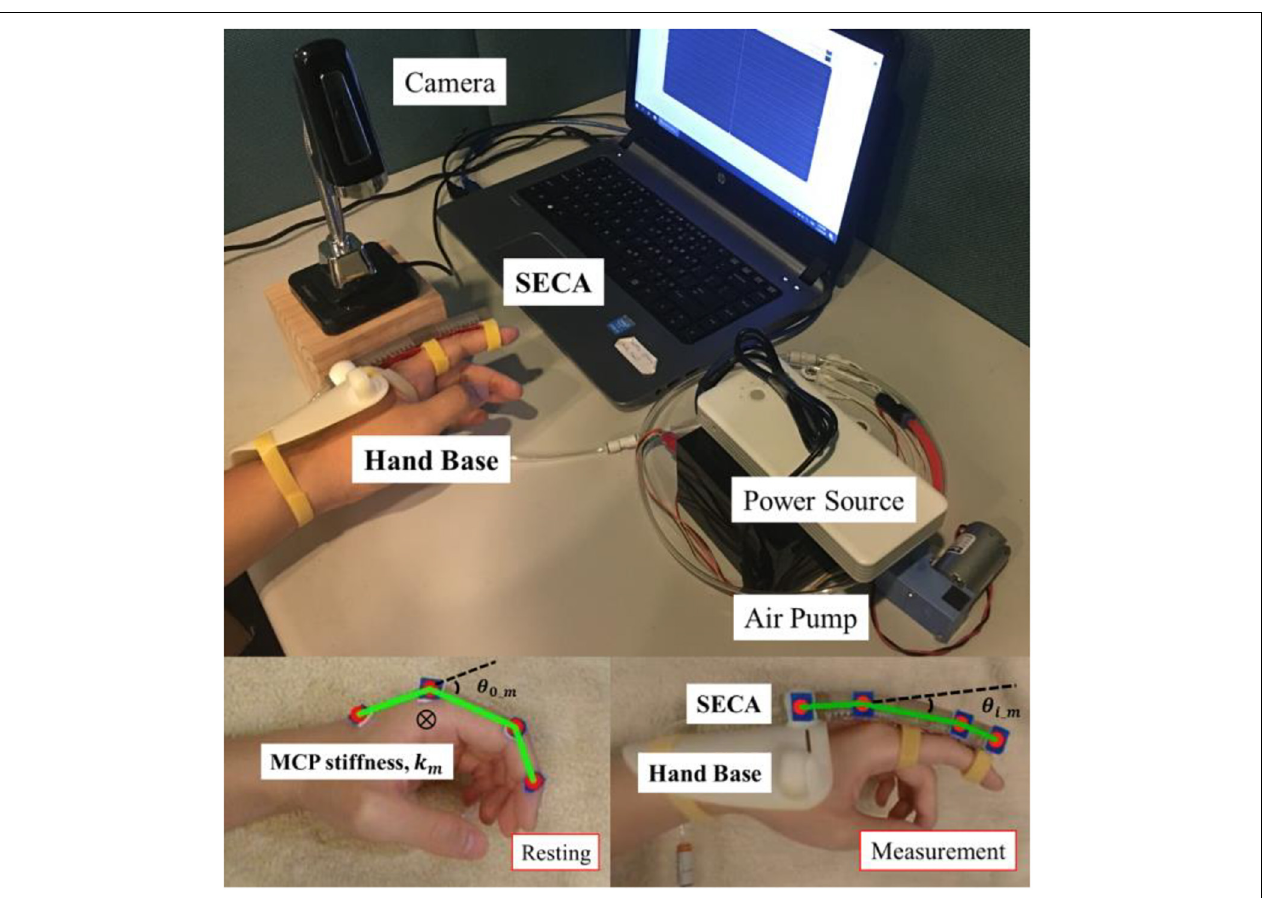
FIGURE 2 | Attachment of the SECA to finger with the hand base during MCP joint stiffness measurement. θ 0_ m is the initial resting angle of MCP joint, θ i _ m is the extended MCP joint angle upon wearing of the SECA in a unpressurized state, and k m is the measured MCP joint stiffness. The hardware setup followed our previous work in Heung et al. (2020). The movement of SECA is controlled by input pneumatic pressure. A camera remains on top of the index finger for recording the passive MCP joint